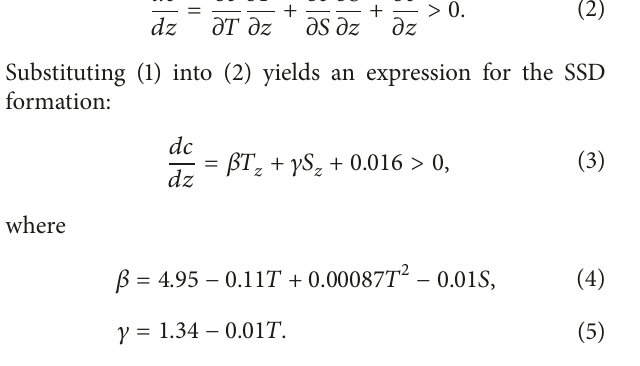
line divided the plane into two areas: the colored areas above the threshold line and the colorless areas under the threshold line. When all of the gradient measurements are located in the colored areas, this indicates that the SSD is present in the corresponding depth. Conversely, once there is a gradient point below the threshold line, the SSD no longer exists from this